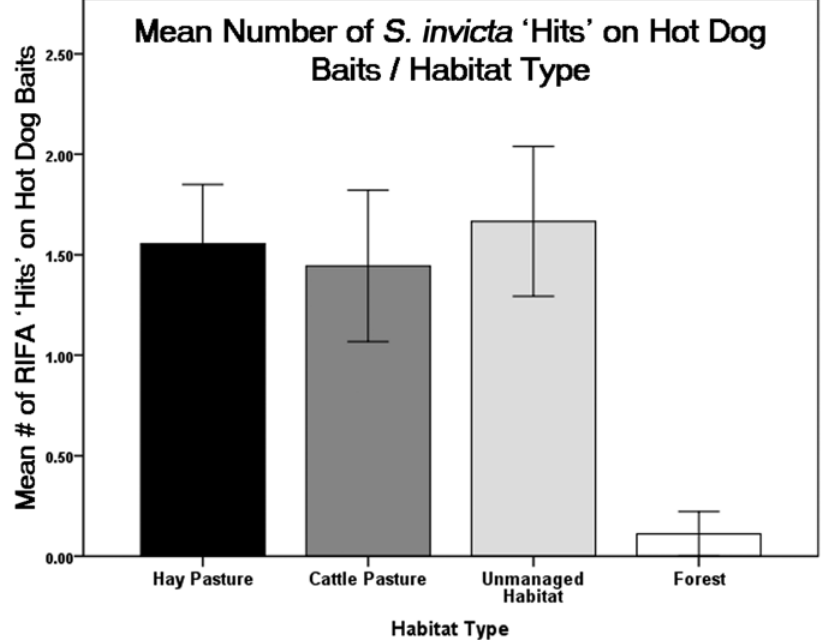
Fig. 3. Mean # of RIFA ‘hits’ on hot dog baits in all habitat types. There were no significant differences in RIFA ‘hits’ on hot dogs in hay pastures, cattle pastures, or unmanaged habitats, and ‘hits’ in each of these habitat types was significantly greater than in forest